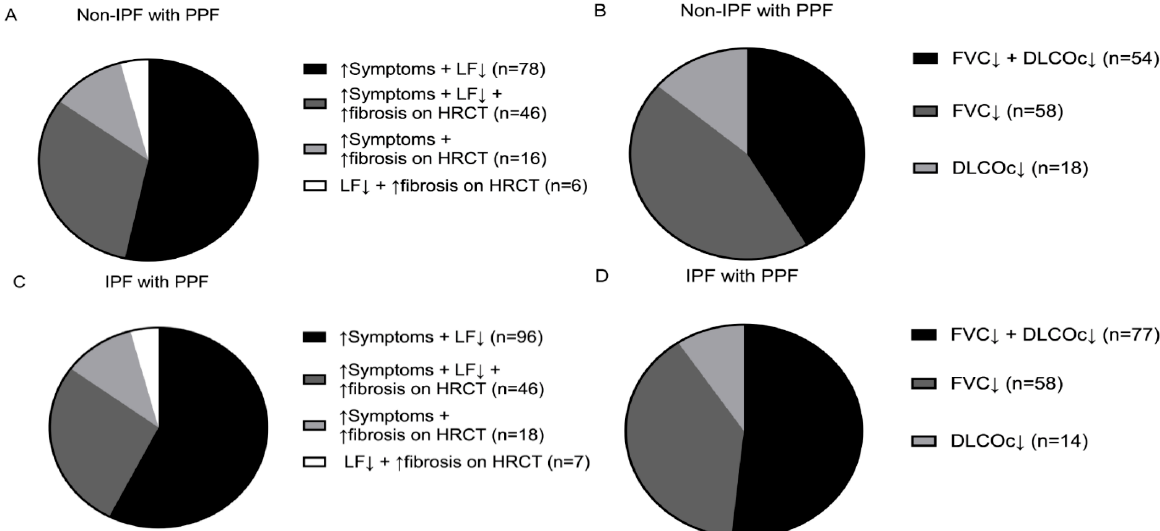
Figure 3. Overview of PPF and specific lung function criteria met in non-IPF and IPF. ( A ) In non-IPF, an overview of the reasons patients had PPF. Patients who experienced an increase in respiratory symptoms and lung functional decline are shown in black. Patients who fulfilled all three criteria are demonstrated in grey. In light grey, patients who had an increase in cough and/or dyspnea and fibrosis on HRCT. Patients with lung functional decline and increase of fibrosis on HRCT are illustrated with the white pie slice. ( B ) First specific PPF lung function criteria met in the non- IPF cohort with PPF. Black shows patients fulfilling both FVC and DLCOc lung function criteria. Patients who only demonstrated ≥ 5% absolute FVC decline are shown in grey and patients who only demonstrated ≥ 10% absolute DLCOc decline are shown in light grey. ( C ) The PPF criteria met in the IPF cohort. The colors represent the same criteria as mentioned under ( A ). ( D ) The specific lung function criteria met in IPF; the colors indicate the same lung function criteria stated under ( B